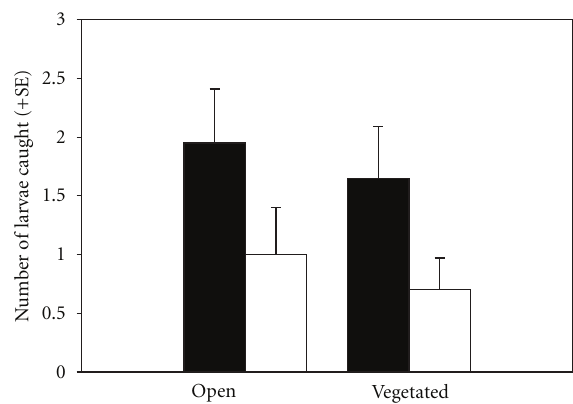
Figure 3: Number of chironomid larvae eaten by juvenile stickle- backs in two structurally di ff erent habitats, in the absence (black bar) and presence (white bar) of a predator. N = 20 for each of the four treatments.